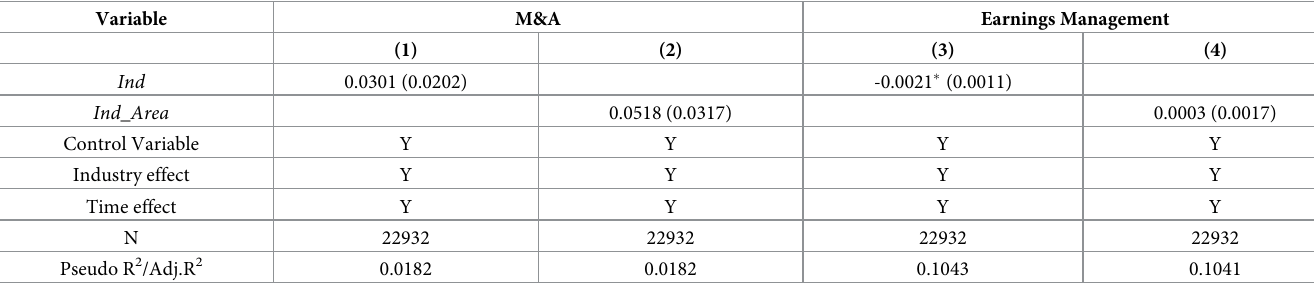
Table 13. Excluding an alternative